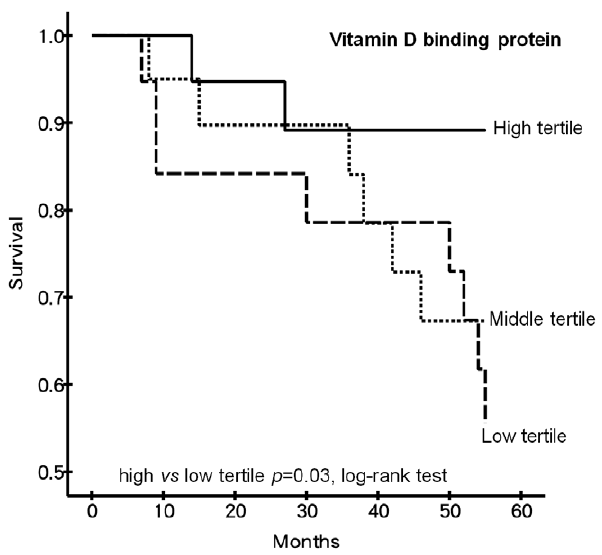
Figure 4. Kaplan-Meier analysis of plasma DBP level in HD patients. HD patients with the lowest plasma vitamin D binding protein level were at the highest risk for mortality than those with the top tertile plasma levels (p=0.03; log-rank